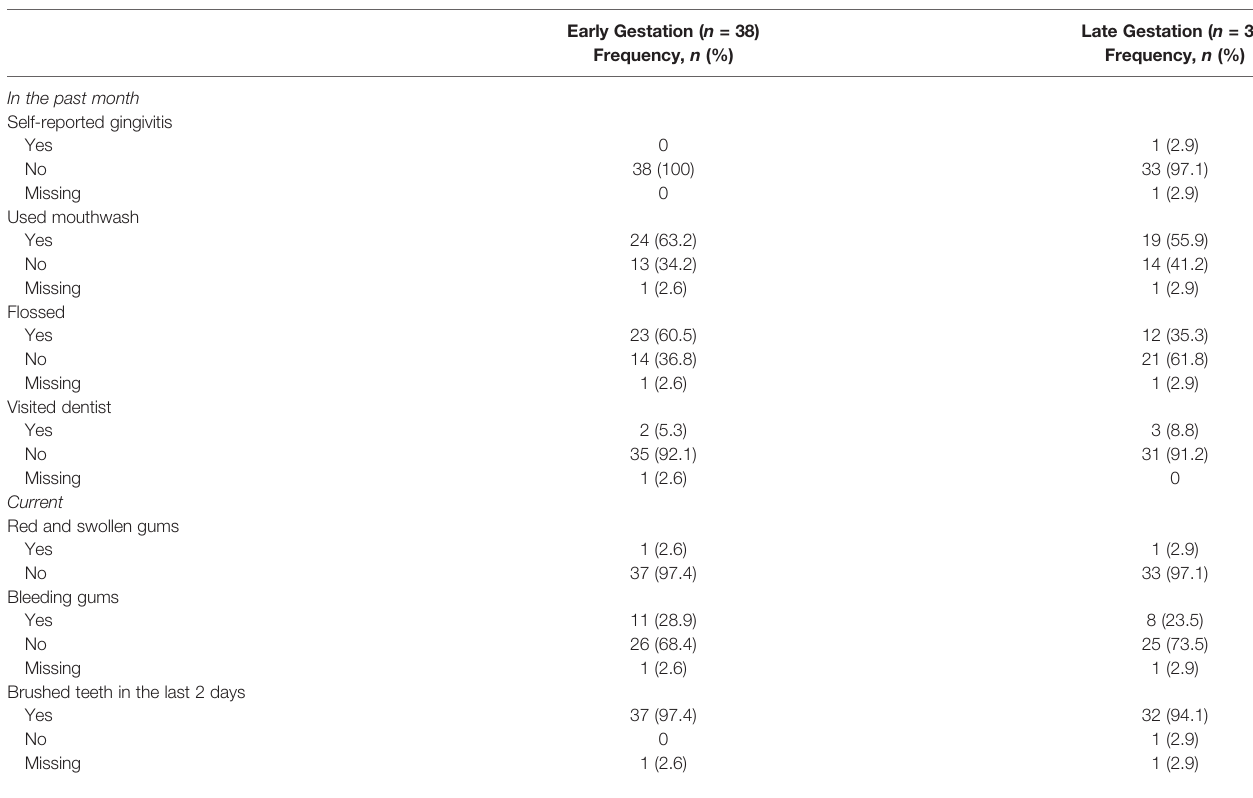
TABLE 2 | Self-reported oral health symptoms and behaviors in early and late gestation.